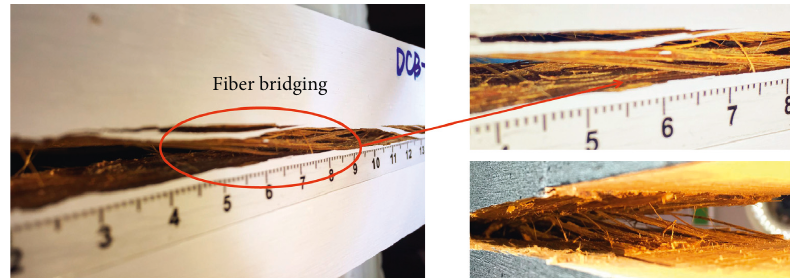
Figure 8: The fiber bridging phenomenon of DCB specimens.